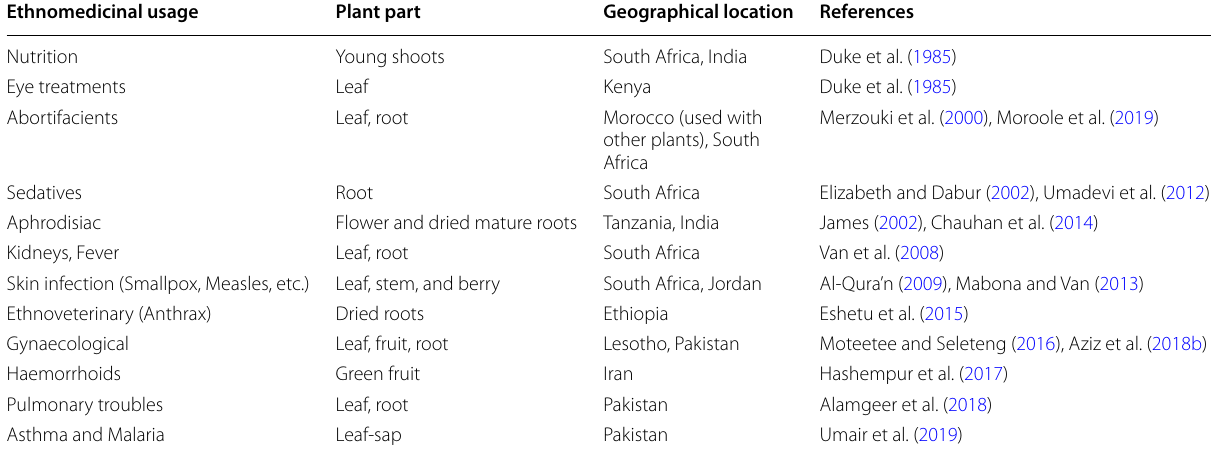
Table 1 Ethnomedicinal usages of W.